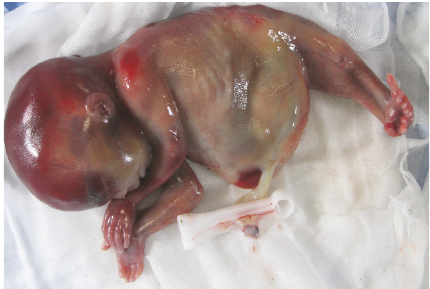
Figure 2: Sirenomelia with fused lower limbs and a bulging abdo-